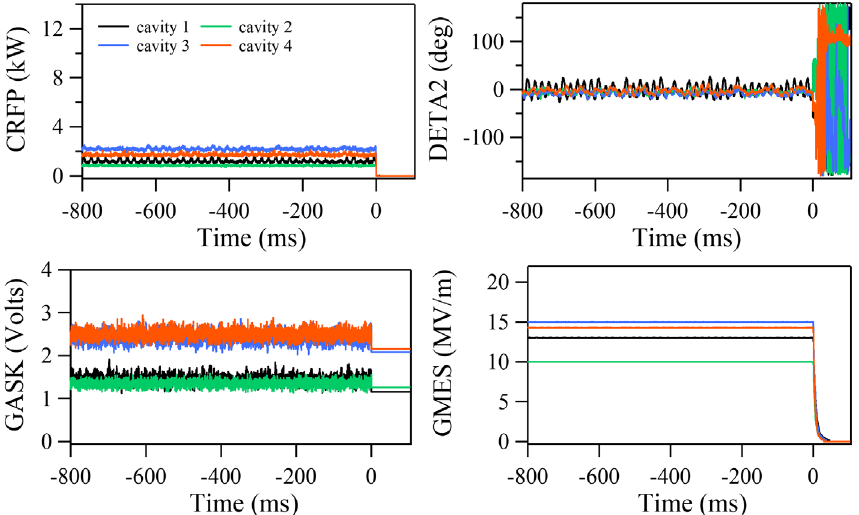
FIG. 17. Waveforms for a multicavity turn-off. The plots display the forward power (top left), detune phase angle (top right), a digital signal proportional to the drive voltage (bottom left), and the measured gradient (bottom right). Only four of the eight cavities are plotted for clarity. Note that the vertical scale of the GASK signal has been